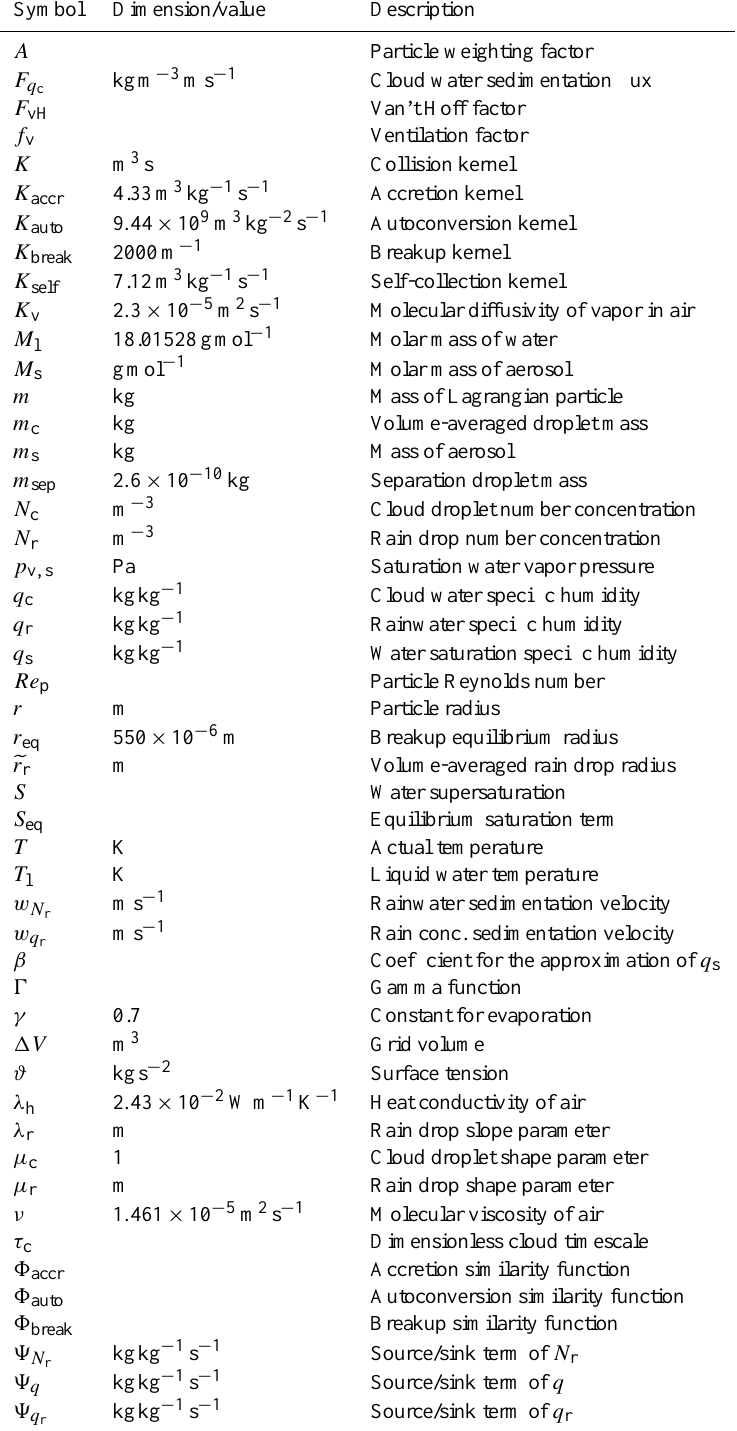
Table 4. List of cloud physics parameters and